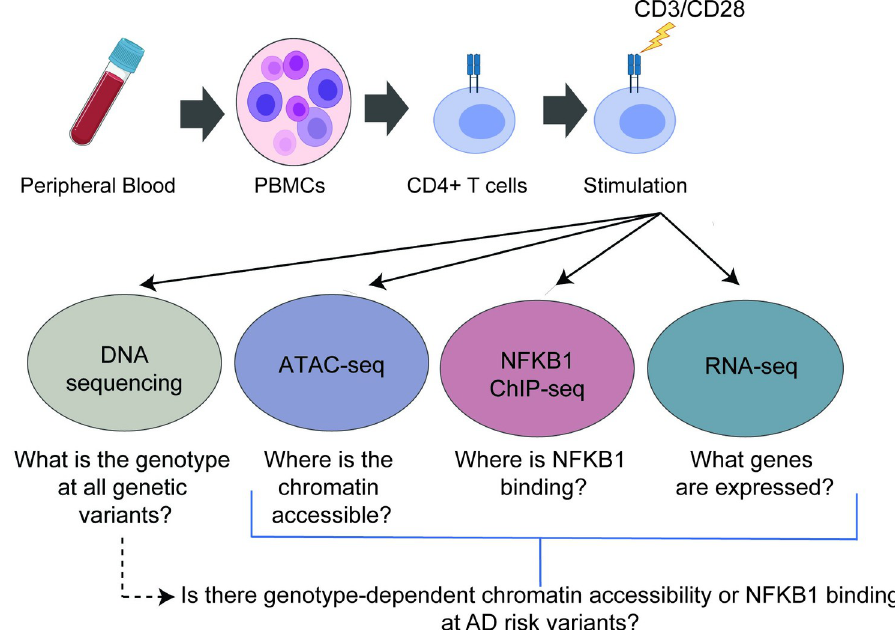
Fig 1. Study Design. Figure created in